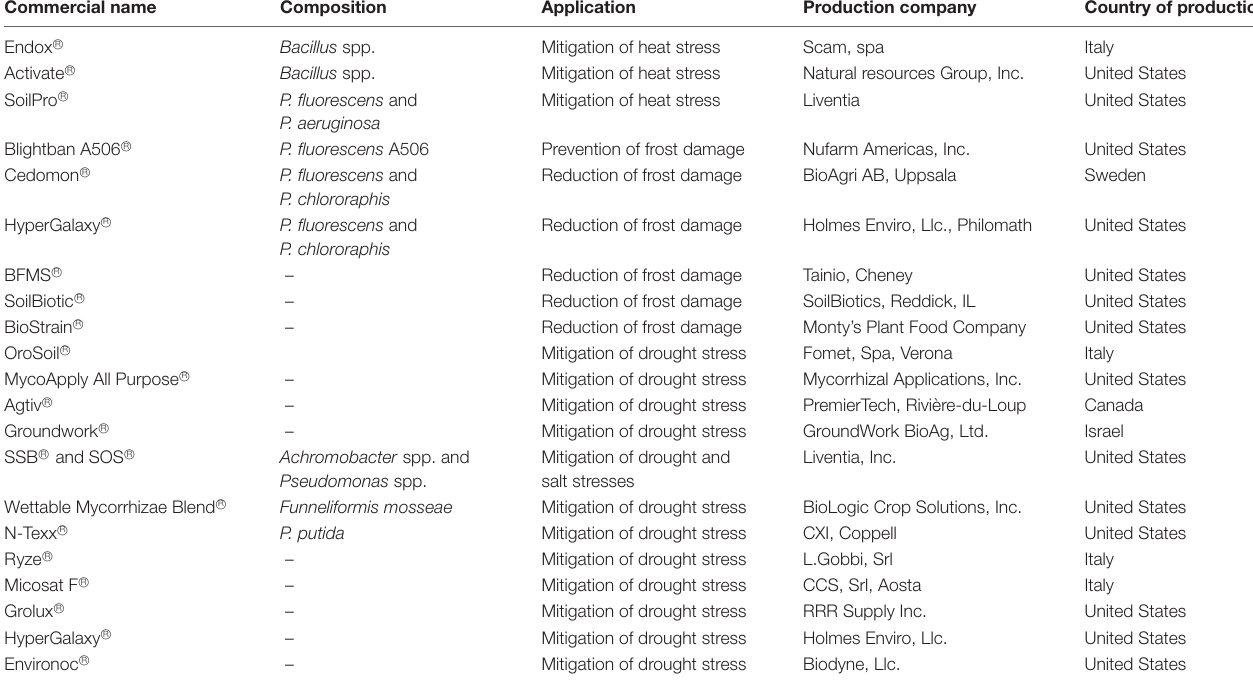
TABLE 3 | Summary of some currently available commercial products used in the mitigating abiotic